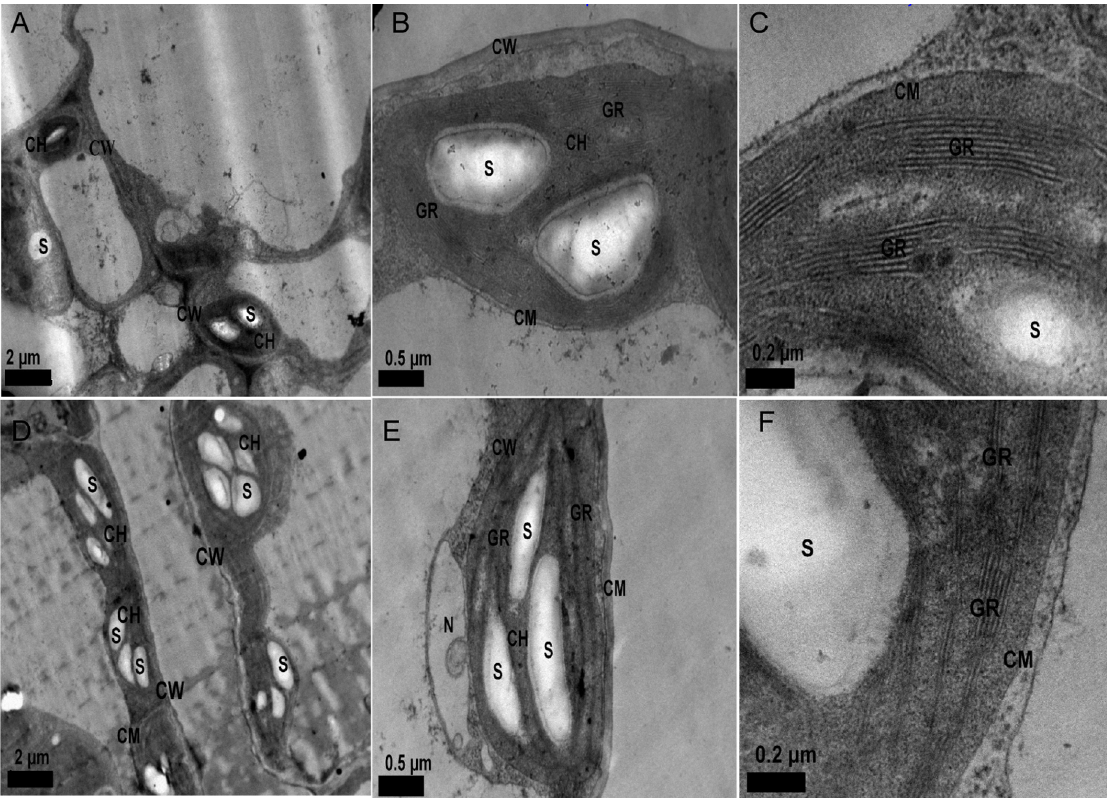
Figure 1. Effects of elevated [CO 2 ] on chloroplast ultrastructure in mesophyll cells of I.indigotica leaf. A – C : Chloroplast ultrastructure of I. indigotica leaf grown in ambient ( 6 8,000, 6 30,000, 6 80,000). D - F : Chloroplast ultrastructure of I. indigotica leaf grown under elevated [CO 2 ] ( 6 8,000, 6 30,000, 6 80,000). S: starch grain; GR: grana layer; CM: chloroplast membrane; CH: chloroplast; CW: cell wall; N: nucleus.